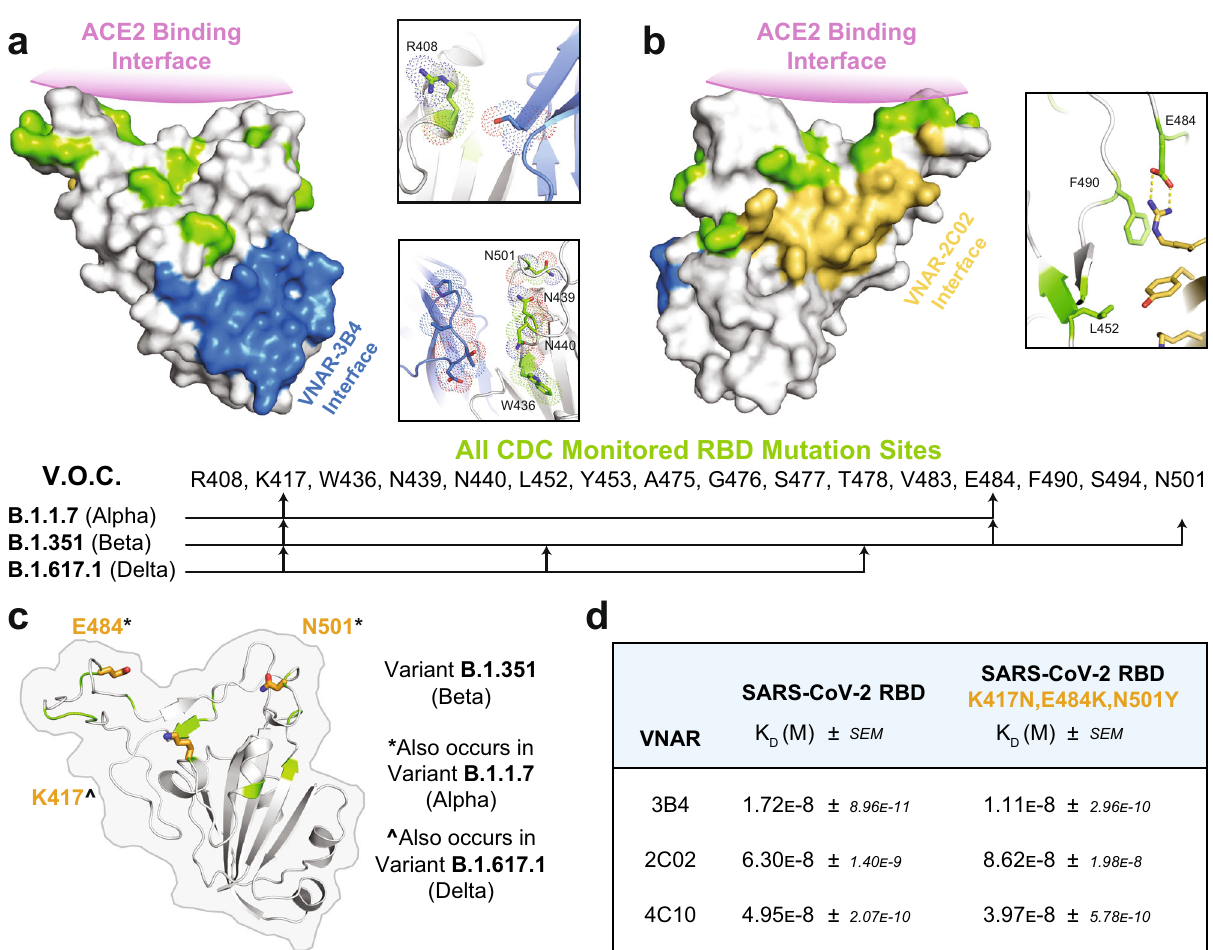
Fig. 6 VNAR binding is resistant to emerging RBD mutations. For panels ( a ) and ( b ), all reported mutation sites (as curated by CDC.gov) are colored green in each RBD structure and the ACE2 binding interface is annotated in purple. The list of mutation sites is shown in the center of the fi gure with arrows drawn to indicate the mutation sites that appear in each of the primary variants of concern (V.O.C). a Surface representation of the RBD with the 3B4 binding interface colored in blue. Insets show mutation sites that occur proximal to 3B4, top: (R408) and bottom:(W436, N439, N440, N501). b A 180-degree rotation of the RBD with the 2C02 binding interface colored in yellow. Inset shows mutations that are a part of or proximal to the 2C02 interface (L452, E484, F490). c A cartoon representation of the RBD with an outline of the surface with mutation sites K417, E484, and N501 displayed as orange sticks. d Summary of binding af fi nities ( K D ) for each of the VNARs to the WT SARS-CoV-2 RBD in comparison to the triple mutant RBD indicated in ( c ). Data shown are a result of triplicate experiments using a BLI binding schema with biotin labeled RBDs (see